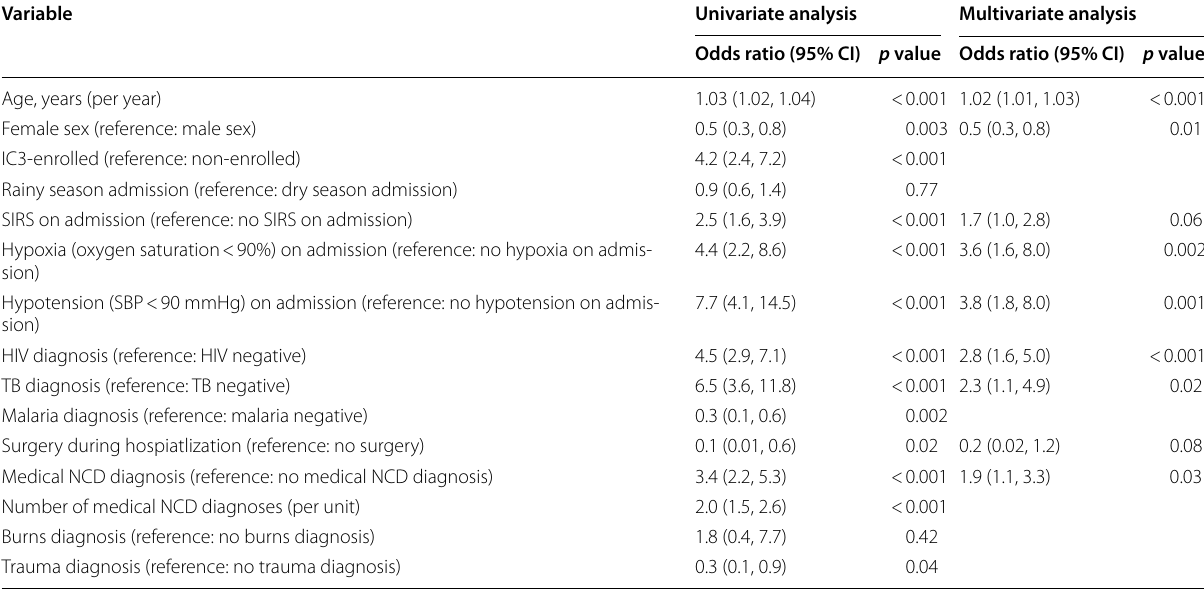
Logistic regression findings for factors associated with patient in-hospital mortality, with both univariate and multivariate findings CI Confidence interval, IC3 Integrated chronic care clinic, SIRS Systemic inflammatory response syndrome, SBP Systolic blood pressure, HIV Human immunodeficiency virus, TB Tuberculosis, NCD Non-communicable